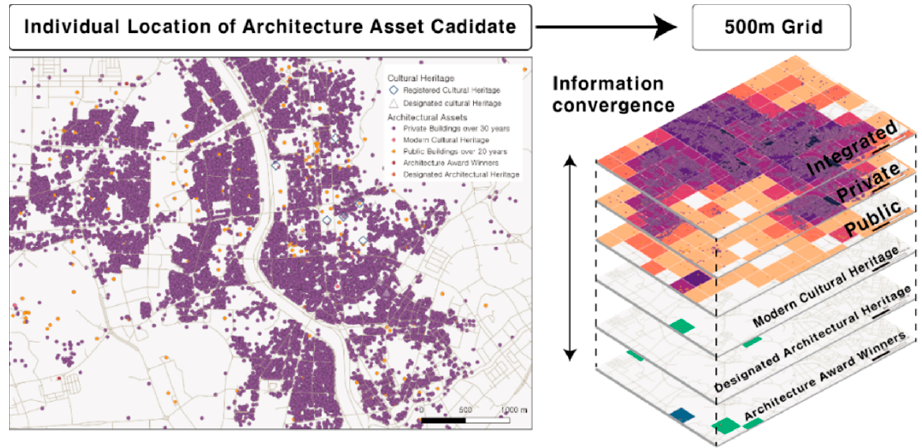
Figure 2. Transformation of grid maps (500 m) of architectural asset candidates based on five crite- ria.